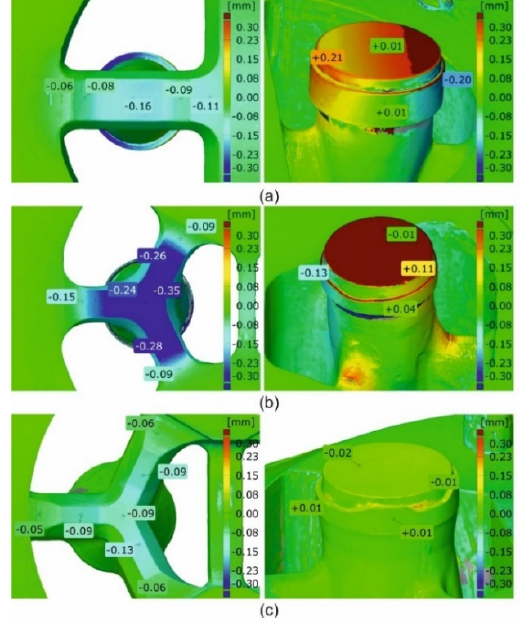
Figure 26. Results of optical scanning of the porthole dies for extrusion of tubes of Ø50 × 2 mm from 7021 alloy: die deflection—close-up of view for die 1 ( a ), die 2 ( b ) and die 3 ( c